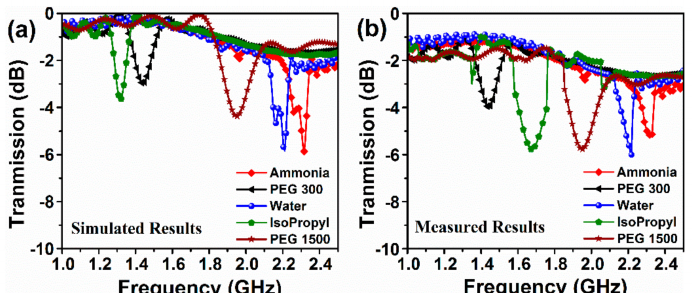
Figure 17. Transmission coe ffi cient of the di ff erent pure chemical liquids over 2.5–3 GHz: ( a ) simulated; ( b ) measured results.